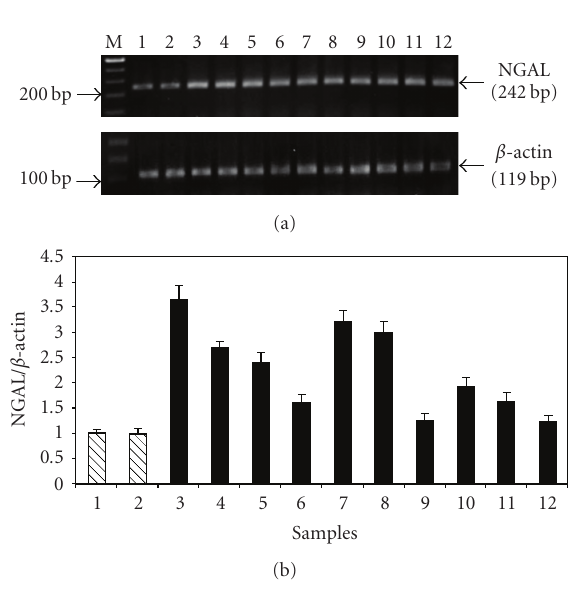
Figure 1: Upregulation of Lcn2 in SM-injured patients. Gene expressions (a) were measured by semiquantitative RT-PCR. Lcn2 was upregulated in SM-injured patients (Lanes 3–12). Only 10 samples have been shown, compared to two normal samples (Lanes 1 and 2). M: 100-bp marker. (b) Ratio of NGAL/beta-actin has also been shown by a